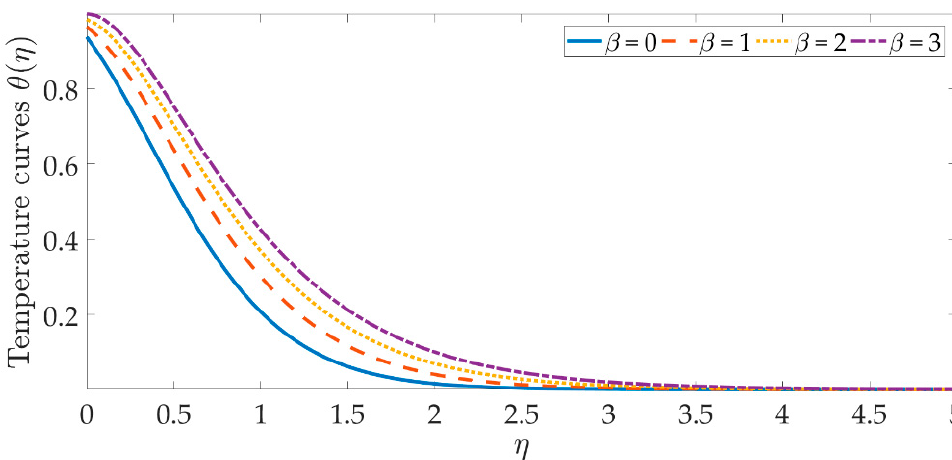
Figure 8. Temperature curves against the multiple values of λ .